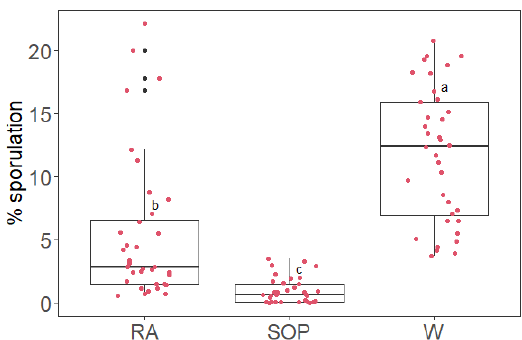
Figure 2. Different levels of sporulation 7 days after the inoculation with Plasmopara viticola on ( a ) water-treated discs (control); ( b ) Salvia officinalis phytocomplex (SOP)-treated discs.